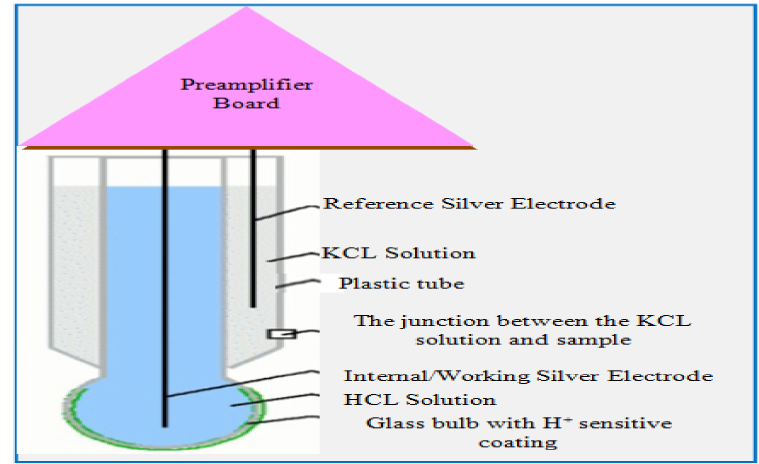
Figure 8. The ph sensor.